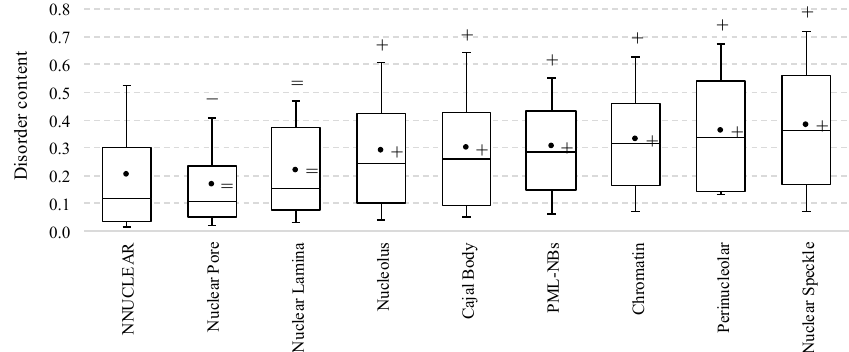
Figure 1. Disorder content of the non-nuclear proteins from the NNUCLEAR dataset and proteins in the considered intra-nuclear compartment from the NUCLEAR ap dataset. The box plots include the first quartile, median and third quartile while whiskers correspond to the 10th and 90th centiles of the disorder content of proteins in a given set. The black circle marker is the mean value of the disorder content. The significance of the differences in the median (mean) disorder content between proteins in a given compartment and non-nuclear proteins is annotated above the whiskers (right of the marker); + and ´ mean that the content of the nuclear proteins is significantly higher and lower ( p -value < 0.01), respectively; “=” means that the difference is not significant ( p -value ě 0.01). Disorder was annotated with the consensus of Espritz and